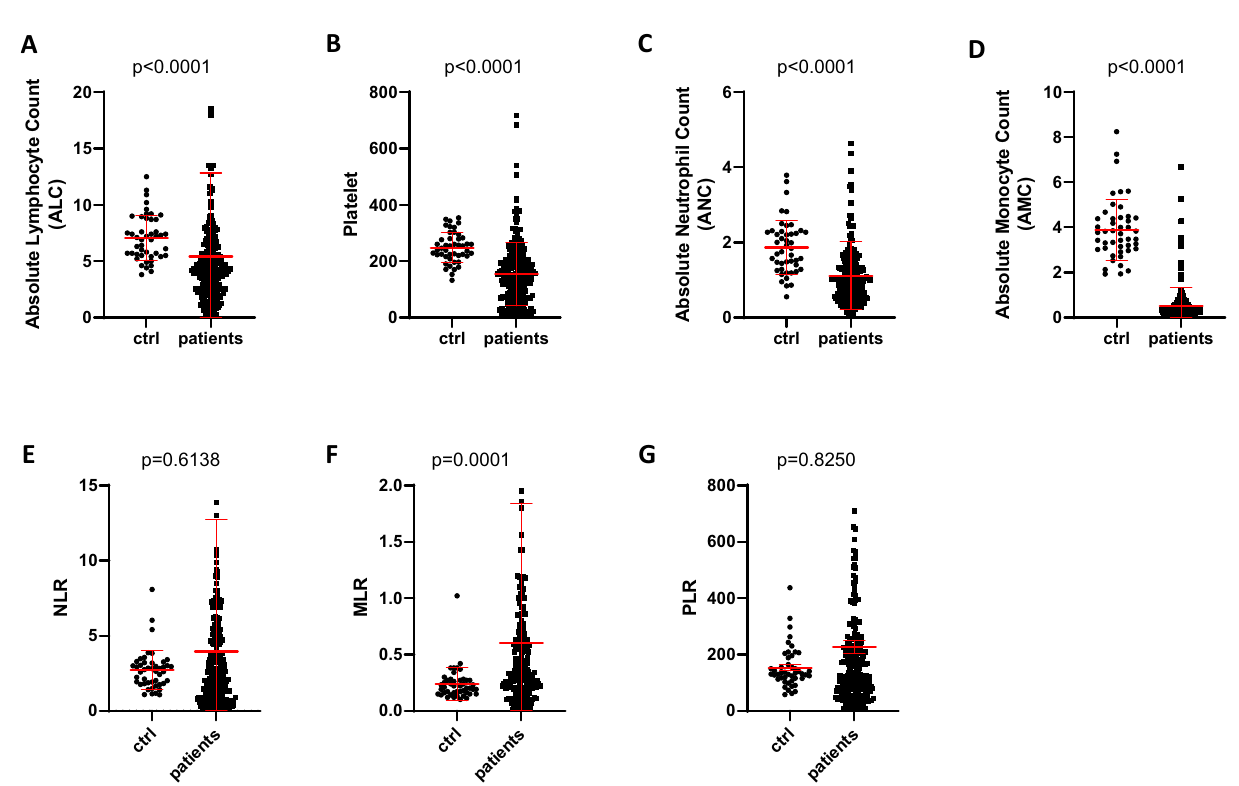
Figure 1. Comparison of ALC, Platelet, ANC and AMC count between healthy individuals (ctrl) and HSCT patients and comparison of NLR, MLR and PLR between healthy individuals (ctrl) and HSCT patients. HSCT Patients showed lower ALC ( A ), Platelet ( B ), ANC ( C ) and AMC ( D ) count compared to healthy individuals (ctrl). NLR ( E ), MLR ( F ) and PLR ( G ) was higher in HSCT patients compared to healthy individuals